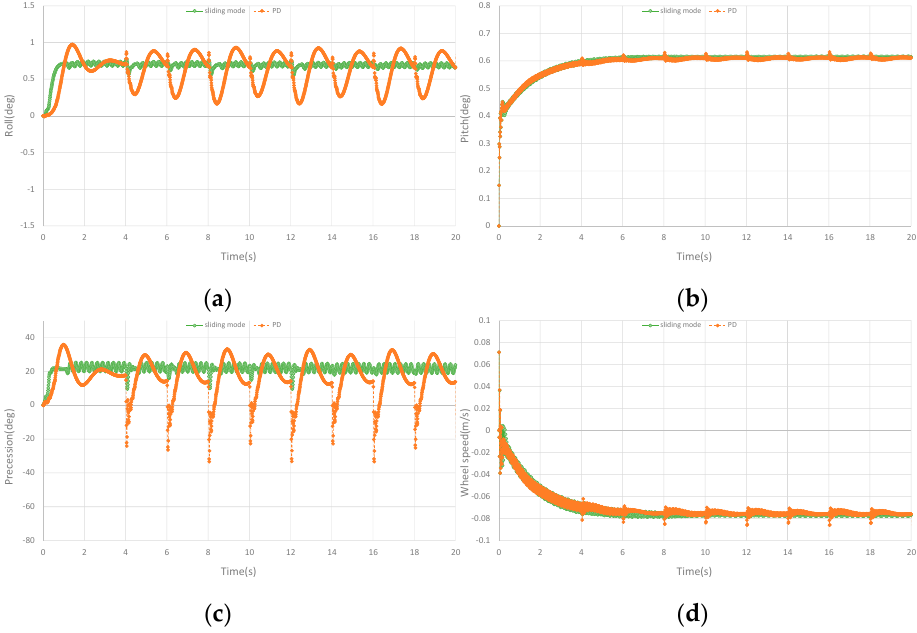
Figure 6. Curves of stochastic pulse interference in simulation. ( a ) The roll angle curve of stochastic pulse interference in the simulation. ( b ) The pitch angle curve of stochastic pulse interference in the simulation. ( c ) The precession angle curve of stochastic pulse interference in the simulation. ( d ) The speed curve of stochastic pulse interference in the simulation.